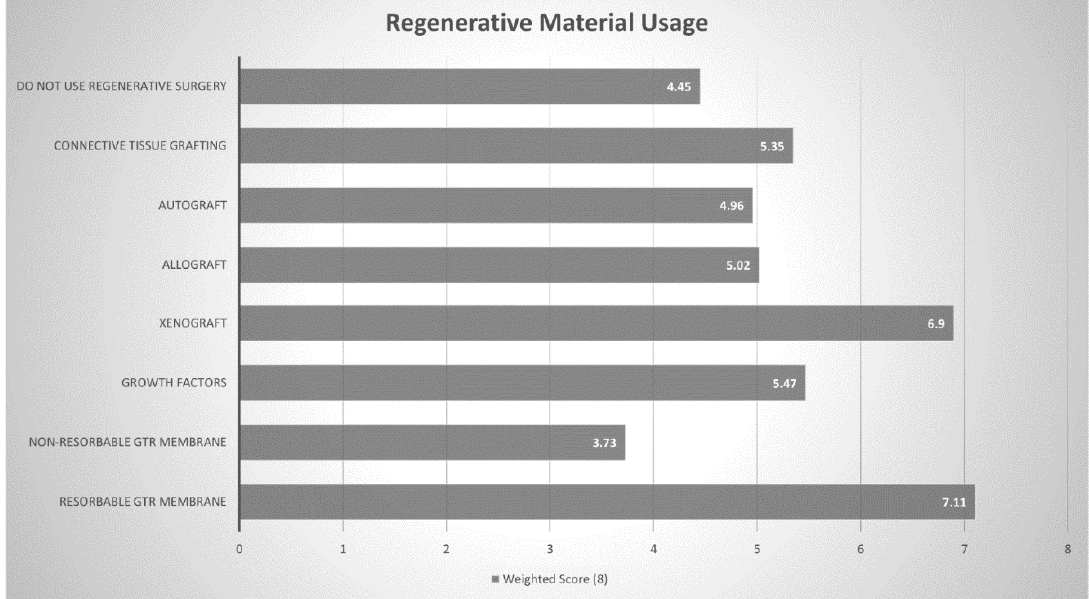
Figure 6. Regenerative Material Weighted Score (Out of 8).